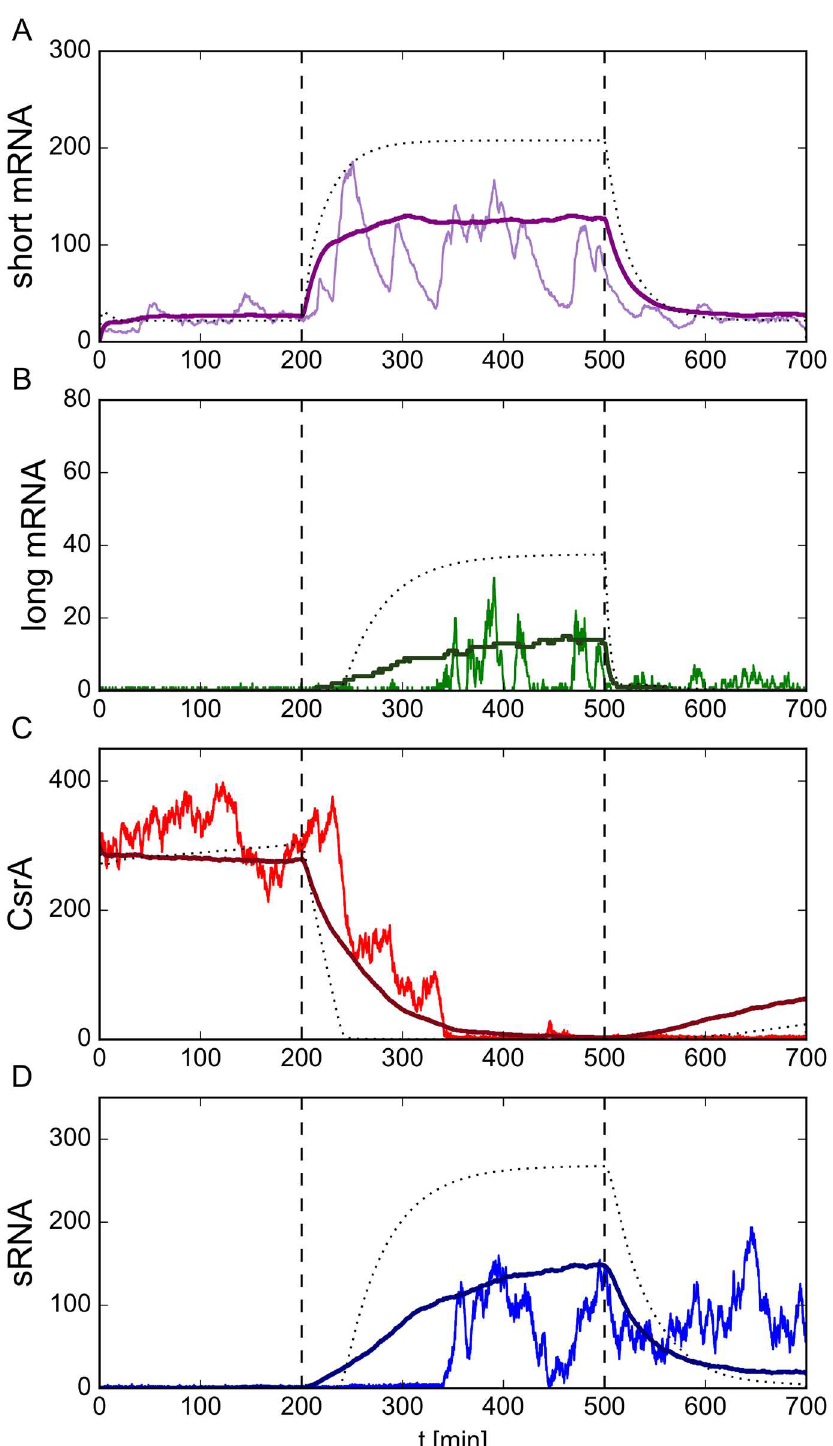
Fig 5. Dynamicalbehavior before and after a realistic SOS response. We simulatedan SOS signal by temporarily up-regulating the LexA auto-cleavage parameter from c p = 0.0 to c p = 6.0 betweenthe two dashed vertical lines at t = 200 min and t = 500 min. The parameter c p gives the rate at which LexA dimers degrade due to the presence of RecA. During the simulation, we tracked the abundance of (A) free short mRNA, (B) free long mRNA, (C) free CsrA dimers and (D)free sRNA over time. In each panel, the